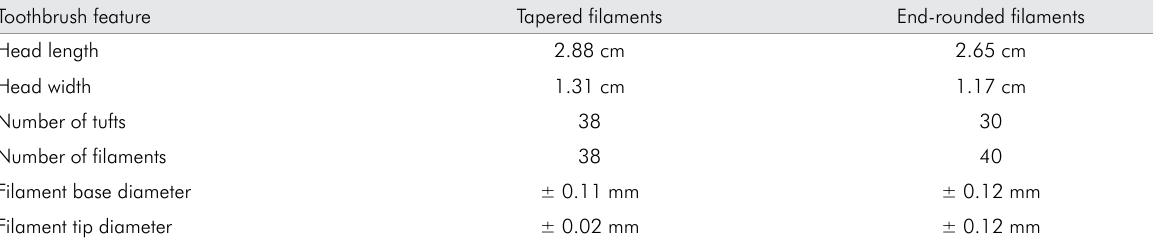
Table 1. Toothbrush